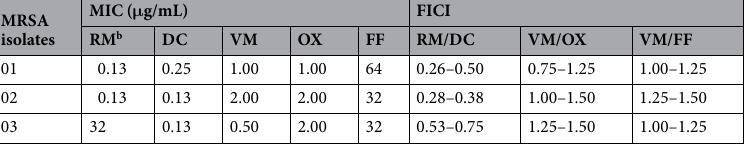
MRSA isloates Combinations a